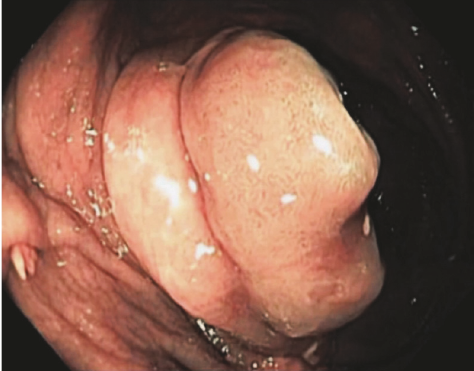
Figure 4: Endoscopic image of the ileocecal valve under digital chromoendoscopy. The small bowel mucosa protrudes or extends outside the ileal opening mimicking an